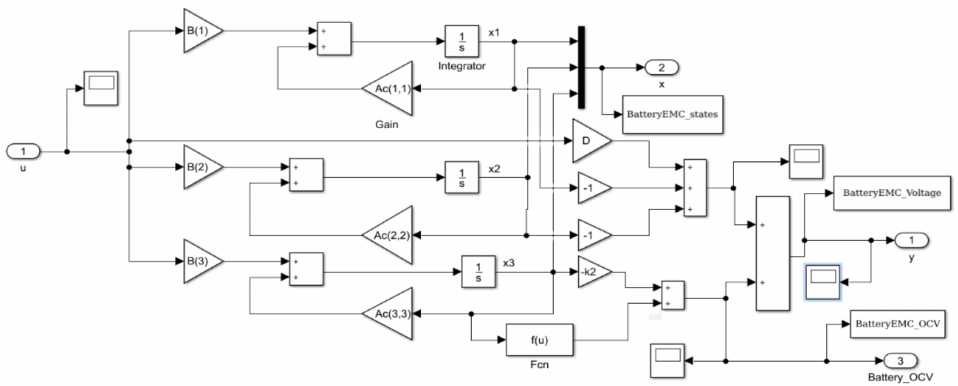
Figure 11. The detailed Simulink model of 2RC EMC Li-Ion battery. The Li-Ion battery 2RC EMC OCV as a function of SOC for an UDDS cycle charging current profile test is shown in Figure 12. The Li-Ion battery 2RC EMC SOC versus ADVISOR estimate on MATLAB/SIMULINK platform are shown on the same graph in Figure 13.